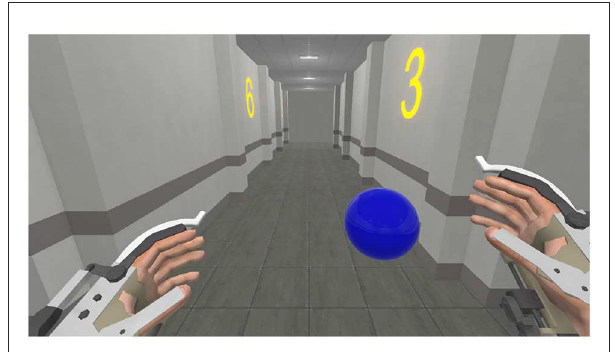
FIGURE1 Screenshot from the virtual environment. The patient was asked to reach the blue sphere with his right